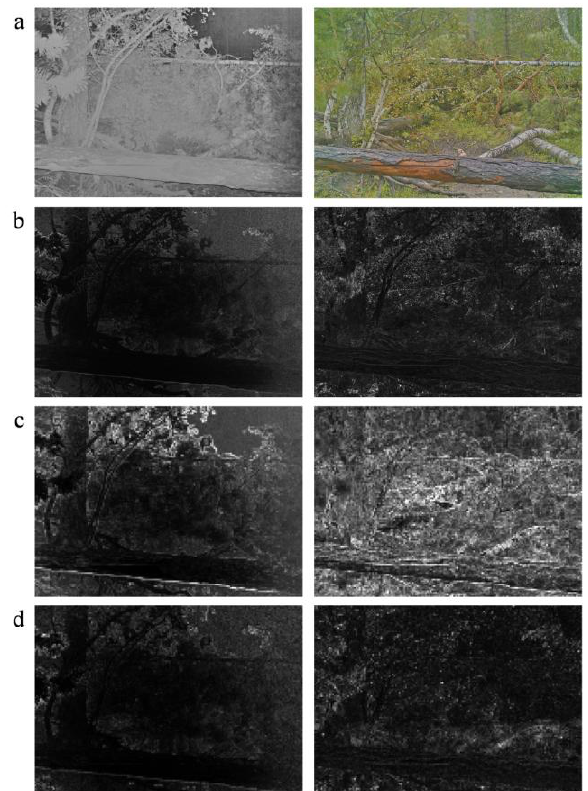
Figure 5. Examples of background model maps: a) mean value, b) pixel standard deviation, c) mean of block based